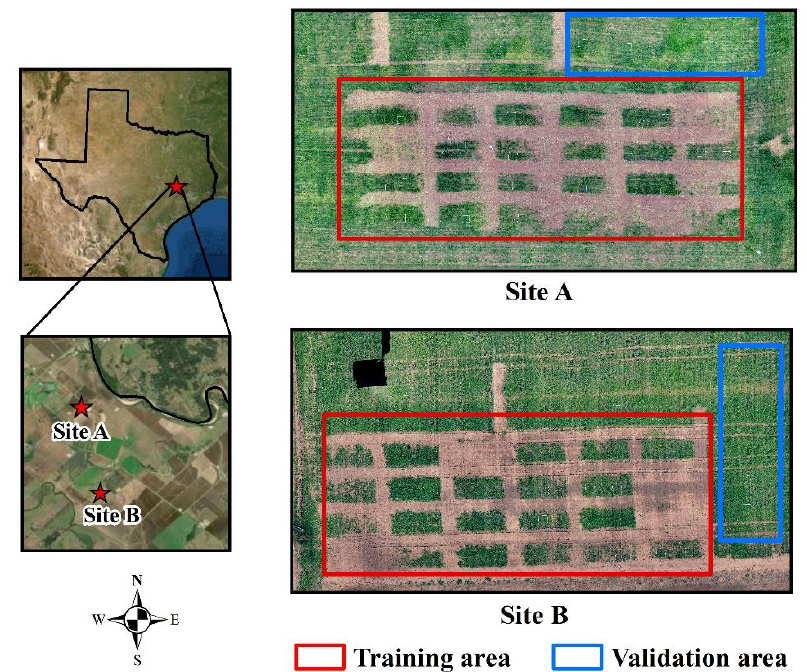
Figure 1. Study locations (Burleson county, Texas, U.S.) and experimental setup for detecting Italian ryegrass and evaluating the competitive response with wheat using unmanned aerial vehicle (UAV)-based aerial true color imagery (spatial resolution 3 mm / pixel). The study locations are located approximately 4 km apart and are unique in edaphic characteristics. Training area includes all the experimental units that would be used for building predictive models and validation area includes the area that would be subjected to validate the accuracy of the model.